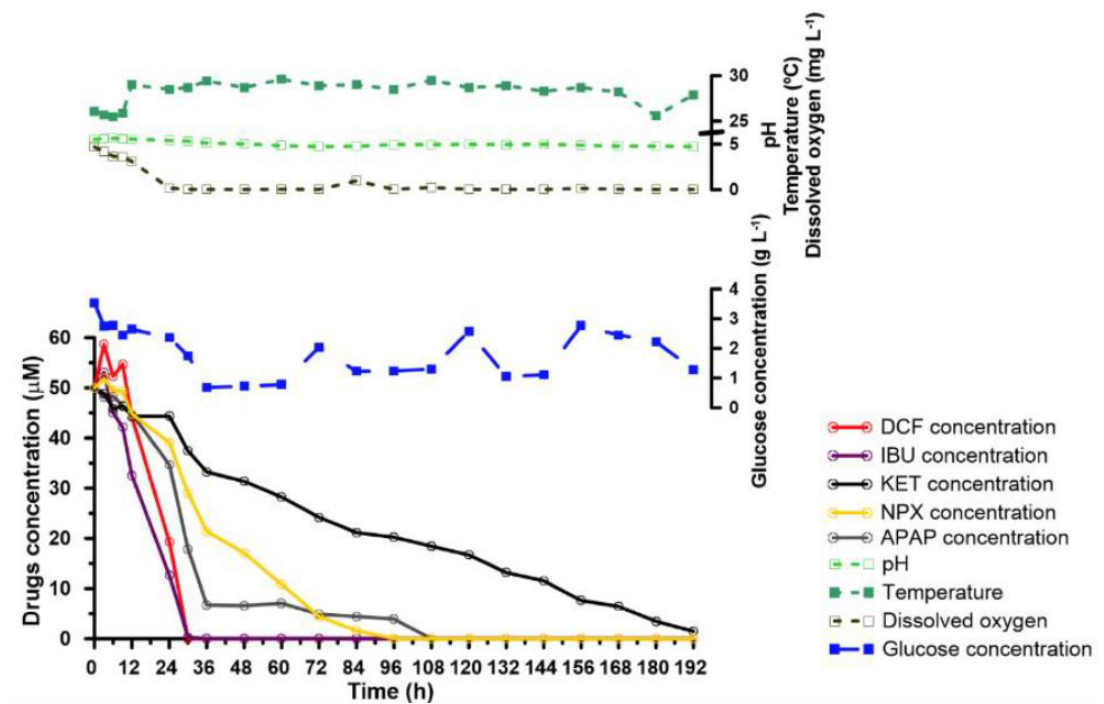
Figure 3. Biodegradation evolution of the NSAIDs/analgesic mix at batch feed bioreactor scale by Penicillium oxalicum . A liquid growth degradation system incubated for 192 h was used under agitation and aeration. Key: acetaminophen (APAP); diclofenac (DFC); ibuprofen (IBU); ketoprofen